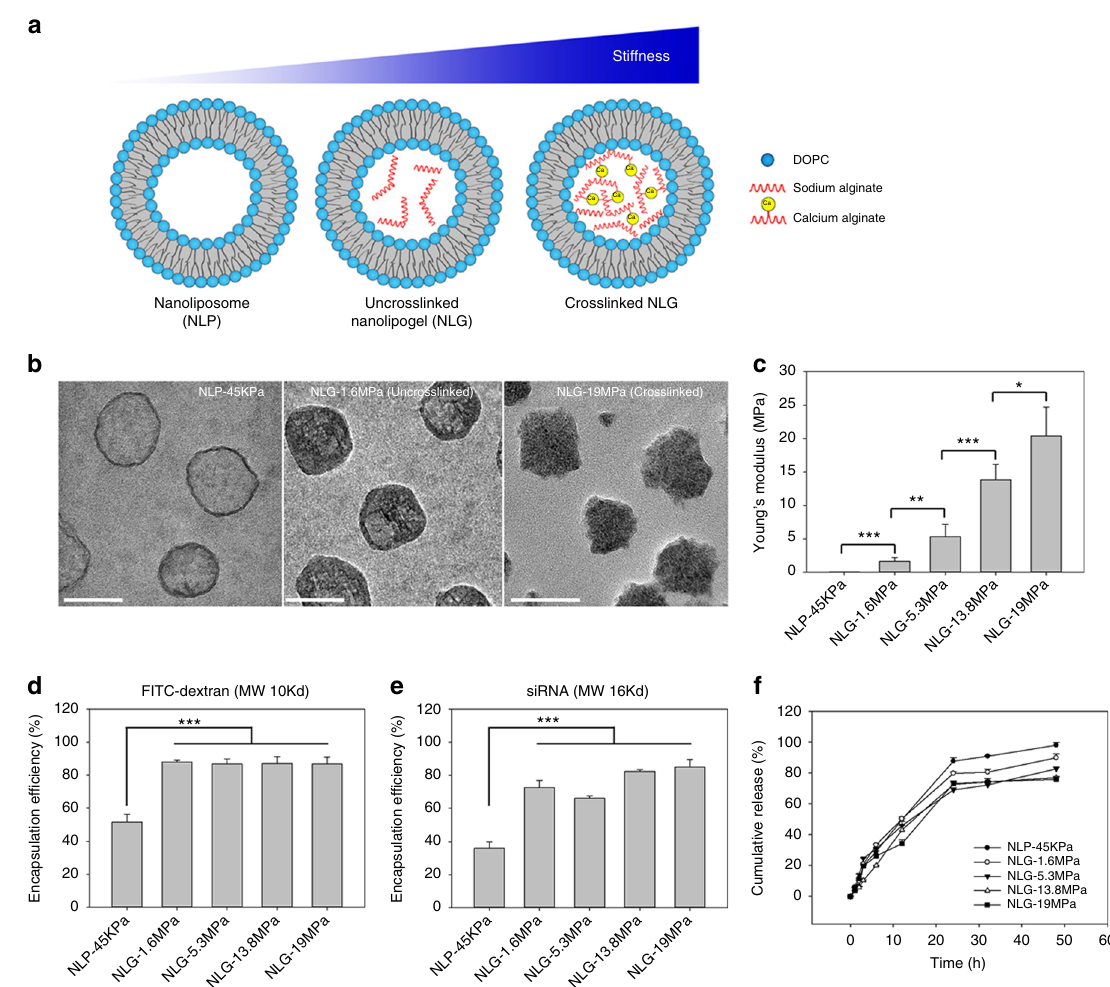
Fig. 1 Synthesis and characterization of NLP and NLGs with varying elasticity. a Schematic illustration of nanoliposome – hydrogel complex system. NLP represents nanoliposome encapsulating PBS. Uncrosslinked NLG represents nanoliposome encapsulating uncrosslinked alginate (0 mM CaCl 2 ). Crosslinked NLG represents nanolipogel encapsulating 1 – 5 mM CaCl 2 crosslinked alginate. b The internal structure of NLP-45KPa, NLG-1.6MPa, and NLG- 19MPa characterized by TEM. Scale bars represent 100 nm. c The Young ’ s moduli of synthesized NLP and NLGs characterized by AFM. The encapsulation ef fi ciencies of FITC-dextran ( d ) and siRNA ( e ) in synthesized NLP and NLGs. f Sustained release pro fi les of synthesized FITC-dextran encapsulating NLP and NLGs. * P < 0.05, ** P < 0.01, *** P < 0.001. The mean values and error bars are de fi ned as mean and S.D., respectively